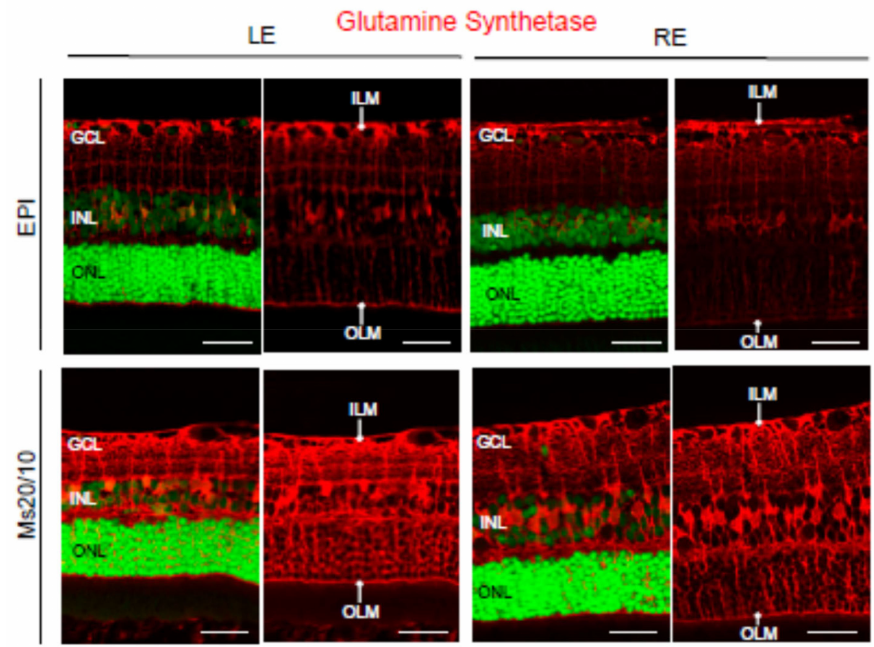
Figure 9. Glutamine synthetase (GS) expression in the glaucomatous EPI and Ms20/10 models. Representative images showed the location and total volume of GS observed in the retinas. GCL: ganglion cell layer; INL: inner nuclear layer; ONL: outer nuclear layer; LE: left eye (control); RE: right eye (treated); ILM: inner limiting membrane; OLM: outer limiting membrane. Scale bar: 34.24 µ